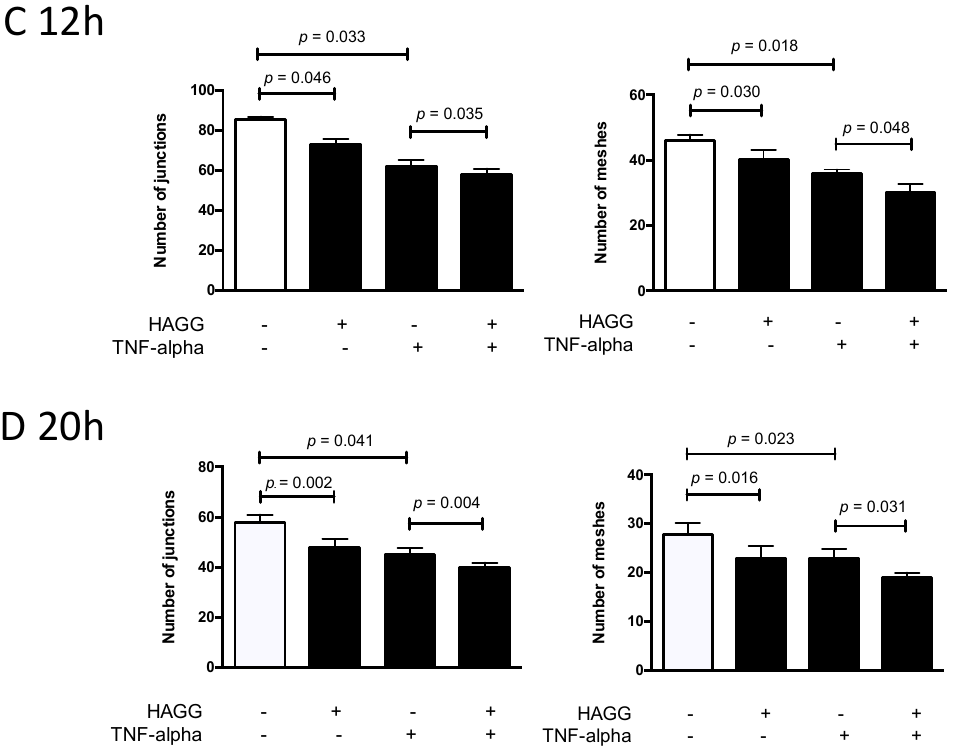
Figure 4. HAGG suppressed GEC tube formation on Matrigel. GECs were seeded on growth factor-reduced Matrigel and cultured with complete medium (control), HAGG (400 µ g / mL), TNF- α (10 ng / mL), or TNF- α plus HAGG, respectively. Representative images of tube formation assay were captured after incubation for 12 h ( A ) and 20 h ( B ), using an inverted phase contrast microscope (magnification: 40 times). Quantifications of tube formation assays at 12 h ( C ) and 20 h ( D ), including the number of junctions and number of meshes, were evaluated by ImageJ software and plotted in column diagrams. Data were presented as mean ± SEM ( n = 3). Comparisons between two groups were analyzed by paired t